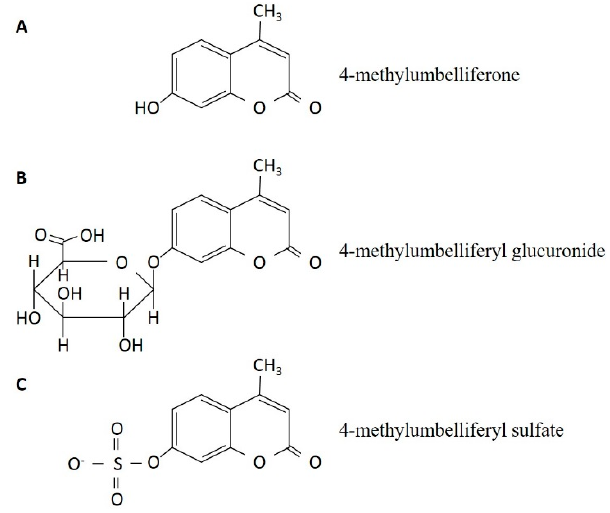
Figure 1. The chemical structure of 4-methylumbelliferone ( A ) and its metabolites, 4-methylumbelliferyl glucuronide ( B ) and 4-methylumbelliferyl sulfate ( C ).